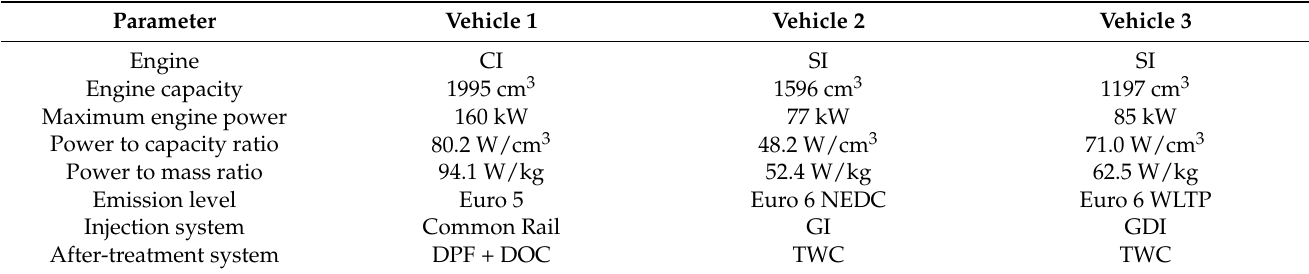
Figure 4. The required road load power versus engine speed for phases of ARTEMIS, WLTC and NDEC driving cycles corresponding to expressway and motorway traffic conditions. Table 1. Essential data of the tested